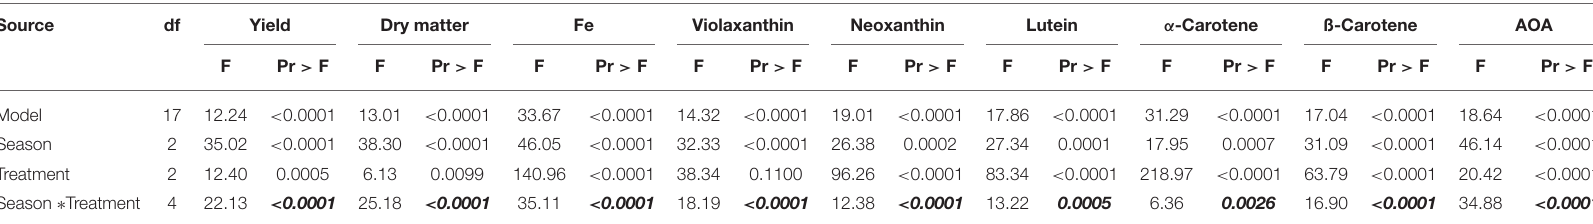
TABLE 3 | Analyses for marketable yield and nutritional content of water spinach under colored poly-net house, white poly-net house, and open field conditions in Taiwan during 2020–2021. Source